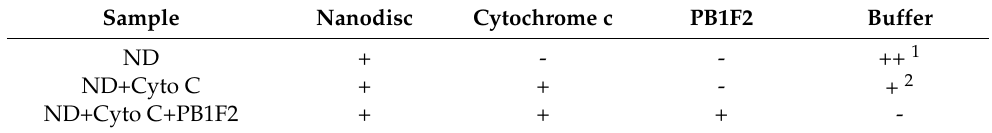
Table 1. Components of the mixture for nanodisc-based fluorescence